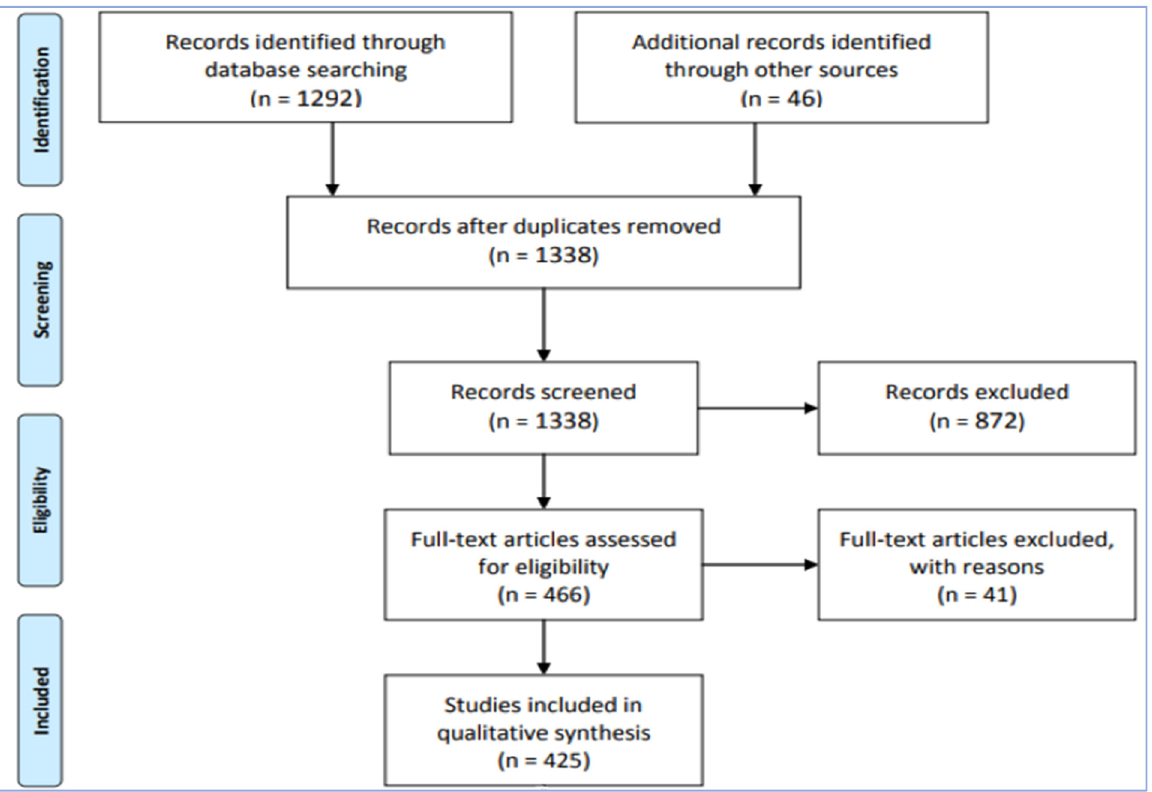
Figure 1. PRISMA